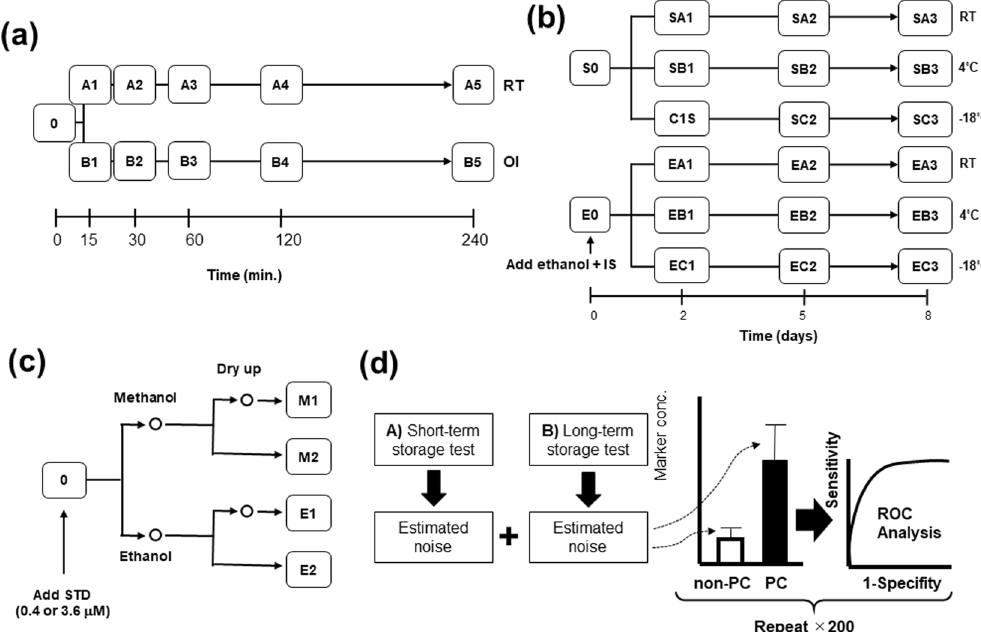
Figure 1. Experimental design. ( a ) Short-term storage. ( b ) Long-term storage. ( c ) Saliva sample processing. ( d ) In silico experiments. Sample 0 indicates the sample at time of collection. ( b ) Two types of processing were performed upon adding ethanol and internal standards (IS) (bottom) or no addition (top). Each processing was evaluated at all sampling times. ( c ) A standard mixture of 0.4 μ M (sample A) and 3.6 μ M (sample B) was added to the saliva samples at 0. ( c ) Saliva samples were treated with methanol or ethanol and processed with or without drying. RT: room temperature; OI: on ice. ( d ) Quantitative experiments to evaluate the effect of noise on the discrimination ability of salivary pancreatic cancer biomarkers. Based on the results of ( a , b ), artificial noises are added to the concentration of markers and receiver operating characteristic analyses were conducted 200 times using various random